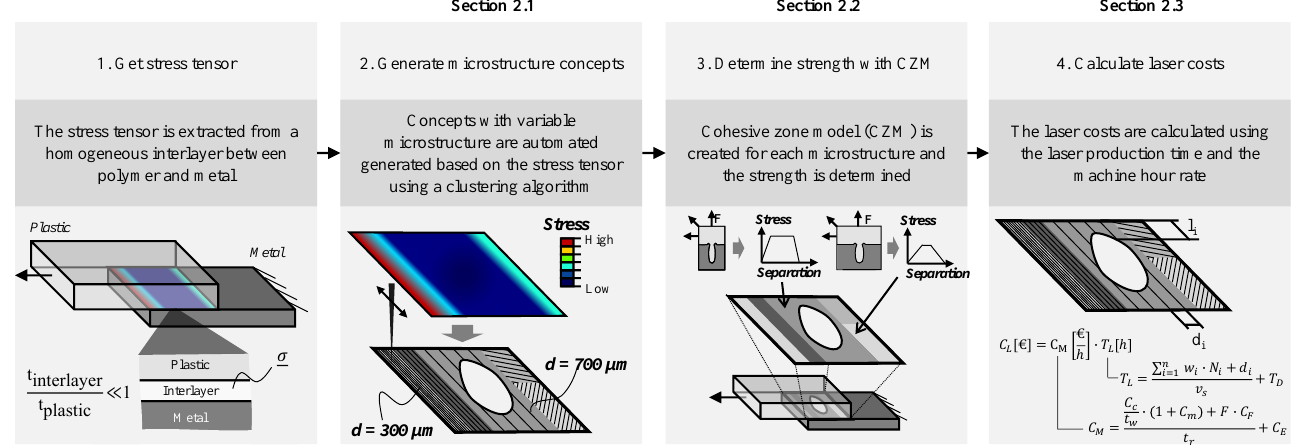
Figure 2. Approach for the automated design of laser-based plastic – metal joints.